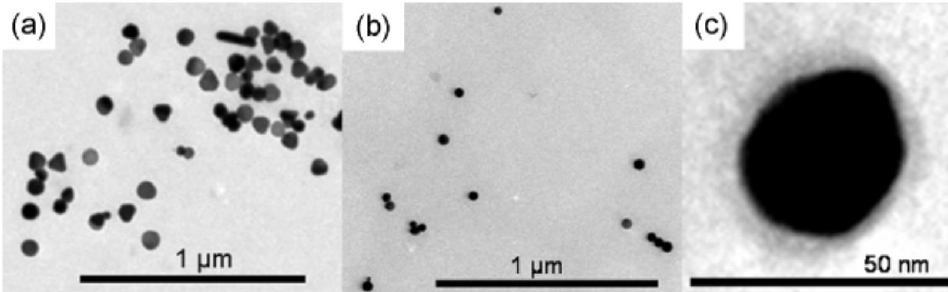
Figure 1. TEM images of the as-prepared silver-chitosan nanoparticles (Ag-CS NPs) with 16.5 mM trisodium citrate (TSC) concentration ( a ) at 35 ± 2 °C, ( b ) at 0 °C, and ( c ) higher magnification of ( b ) showing an Ag NP coated by CS (adapted with permission from reference [10]).